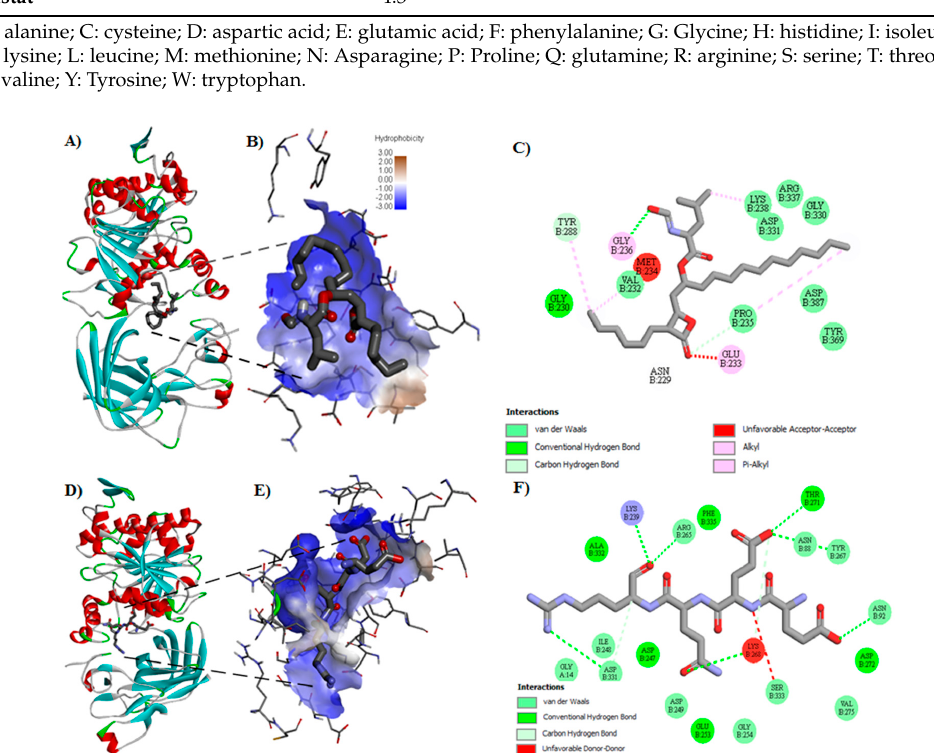
Table 3. Results obtained by molecular docking for cocoa peptides and orlistat on the enzyme pancreatic lipase (PL).